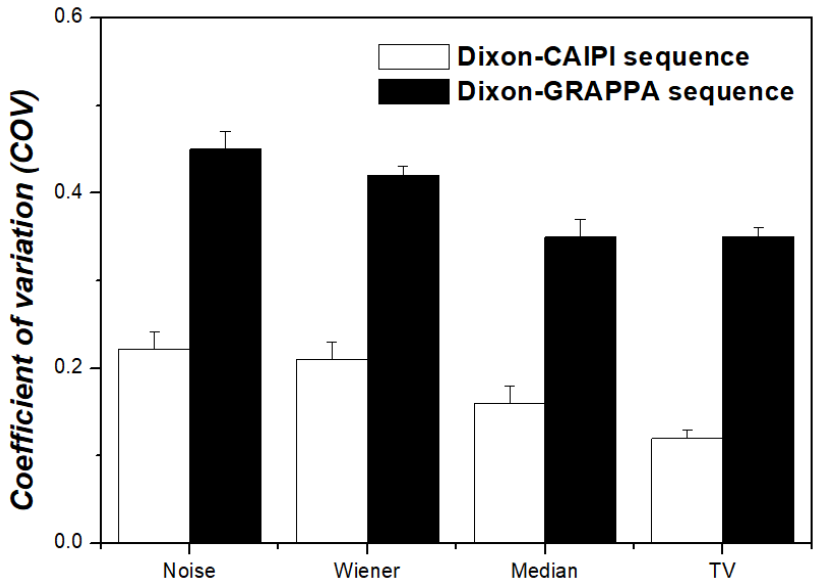
Figure 6. Coefficient of variation (COV) according to noise-reduction techniques between MR- AC Dixon-CAIPI -based and MR-AC Dixon-GRAPPA -based PET images.